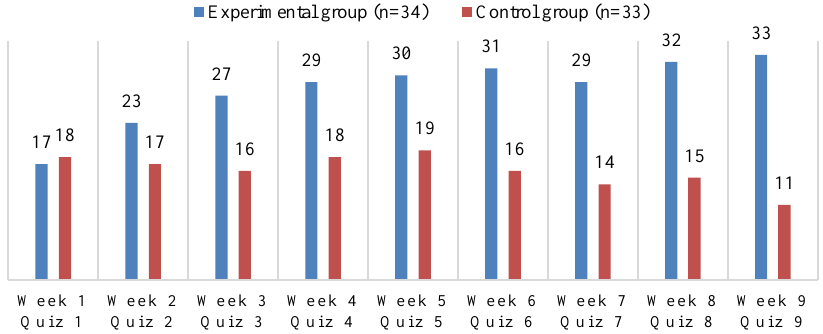
Fig. 4. The number of students who completed the quizzes before the weekly deadlines